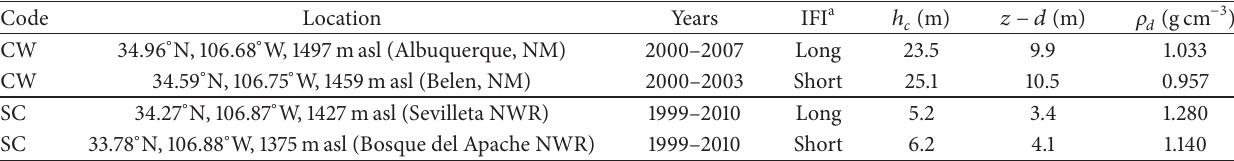
Table 1: Flux sites operating in the Middle Rio Grande valley node of NM-EPSCoR